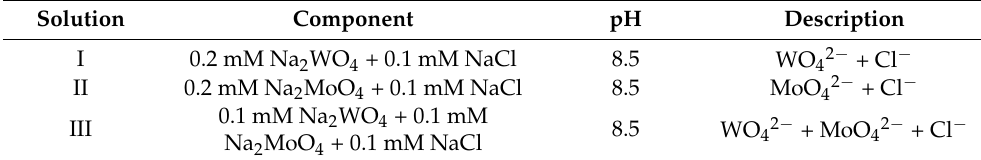
Table 1. Component and pH value of Solution I, Solution II and Solution